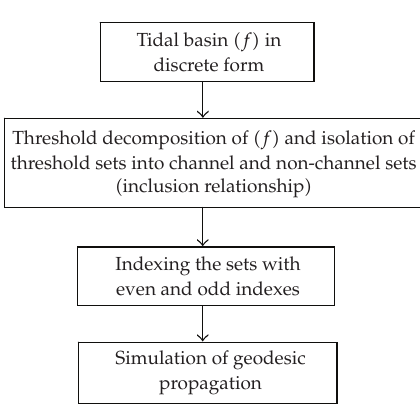
Figure 2: Flowchart depicting various steps involved in modeling and